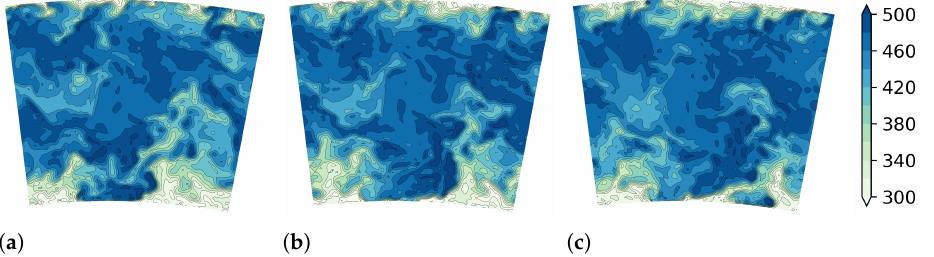
Figure 2. Visualization of the static temperature [ K ] at different instants from the database. ( a ) Instant t 0 . ( b ) Instant t 0 + 20 ∆ t . ( c ) Instant t 0 + 40 ∆ t .